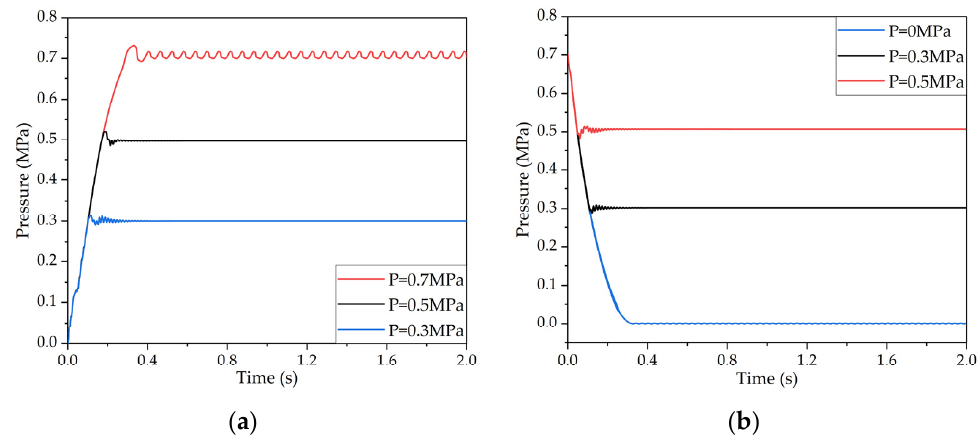
Figure 6. Simulation curves of the pressure regulation characteristics during pressurization and decompression of the LF-APRV: ( a ) pressurization response curve and ( b ) decompression response curve.